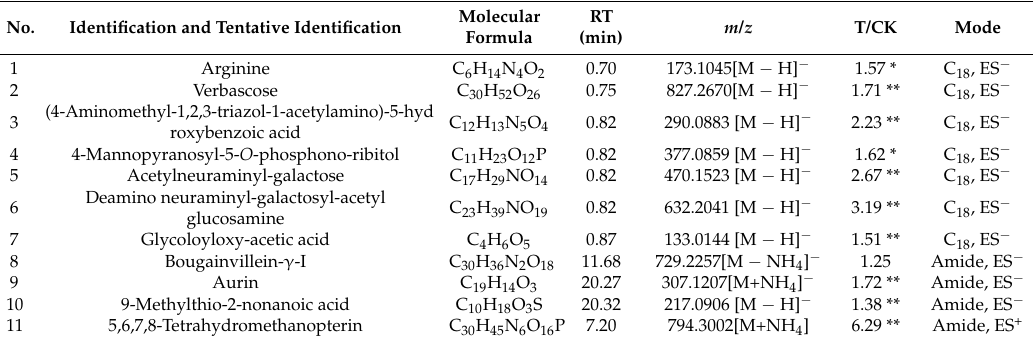
Figure 3. Effect of PGR on secondary metabolites in C. Radix samples. CK, untreated C. Radix sample; T, PGR-treated C. Radix sample. ( A – D ) Principal component analysis (PCA) of secondary metabolites. ( E – G ) S-plot analysis of secondary metabolites, red marked points were selected for further identification. ( A , E ) Chromatographic separation performed using ACQUITY UPLC BEH Amide column in ESI negative mode. ( B , F ) Chromatographic separation performed using ACQUITY UPLC BEH Amide column in ESI positive mode. ( C , G ) Chromatographic separation performed using ACQUITY UPLC HSS T3 C 18 column in ESI negative mode. ( D ) Chromatographic separation performed using ACQUITY UPLC HSS T3 C 18 column in ESI positive mode. Table 3. Major secondary metabolites up-regulated by PGR.